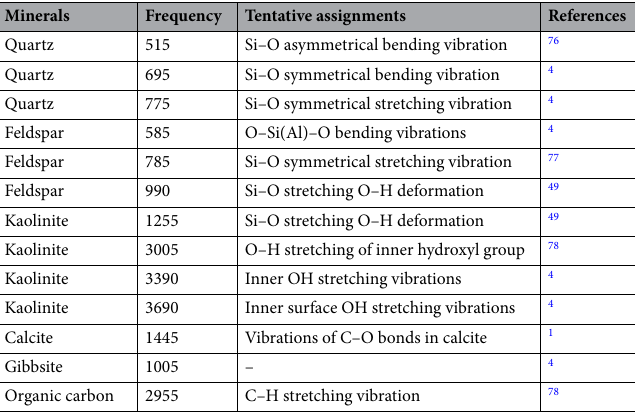
Table 4. Band assignments of different minerals for river sand